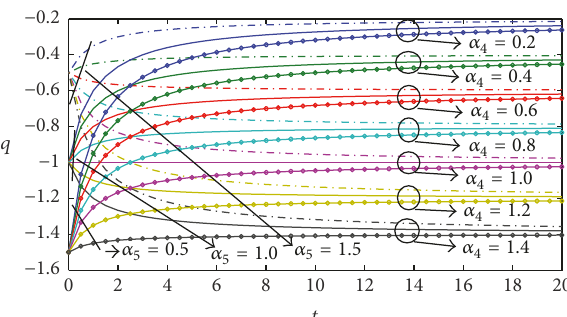
Figure 9: Variation of deceleration parameter against time for fixed 𝛼 5 and different 𝛼